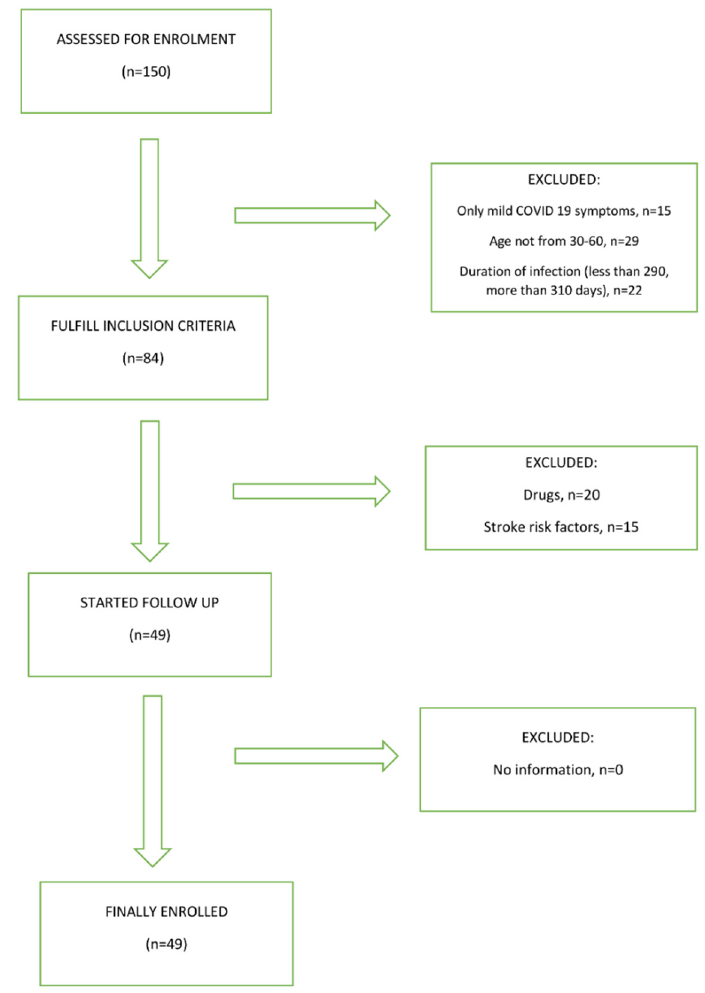
Figure 1. Study flowchart.